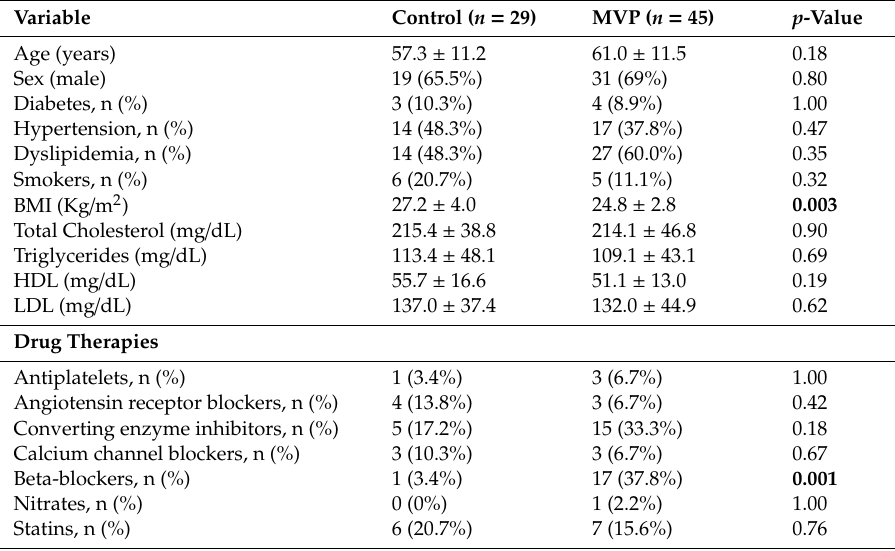
Table 1. Patient